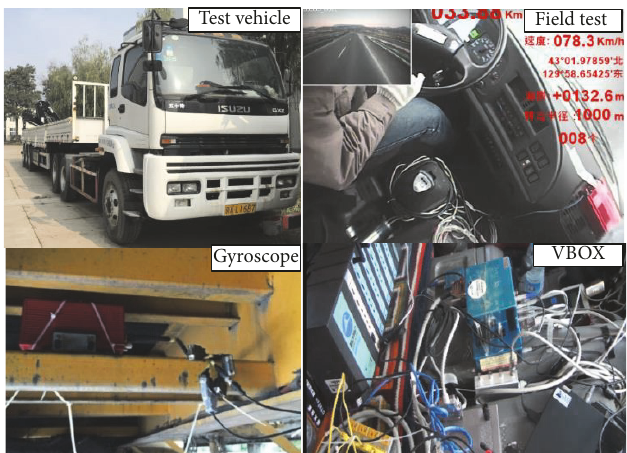
Figure 3: Experimental setup and test instruments.